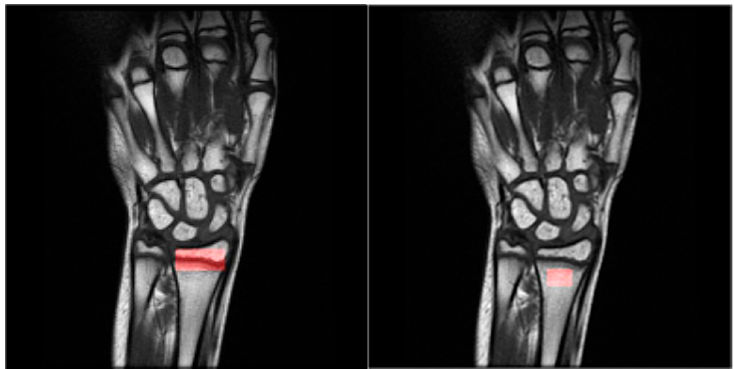
Figure 2. Exemplary magnetic resonance imaging. The red rectangle shows the growth region in the image on the right and bone region on the left scan.